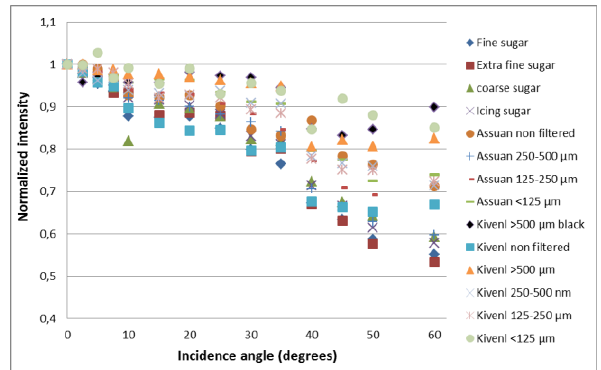
Figure 1. Intensity vs. incidence angle for sand and sugar samples. The intensity is normalized to 1 at 0 ⁰ . The differences in the incidence angle effect are mostly related to target brightness.